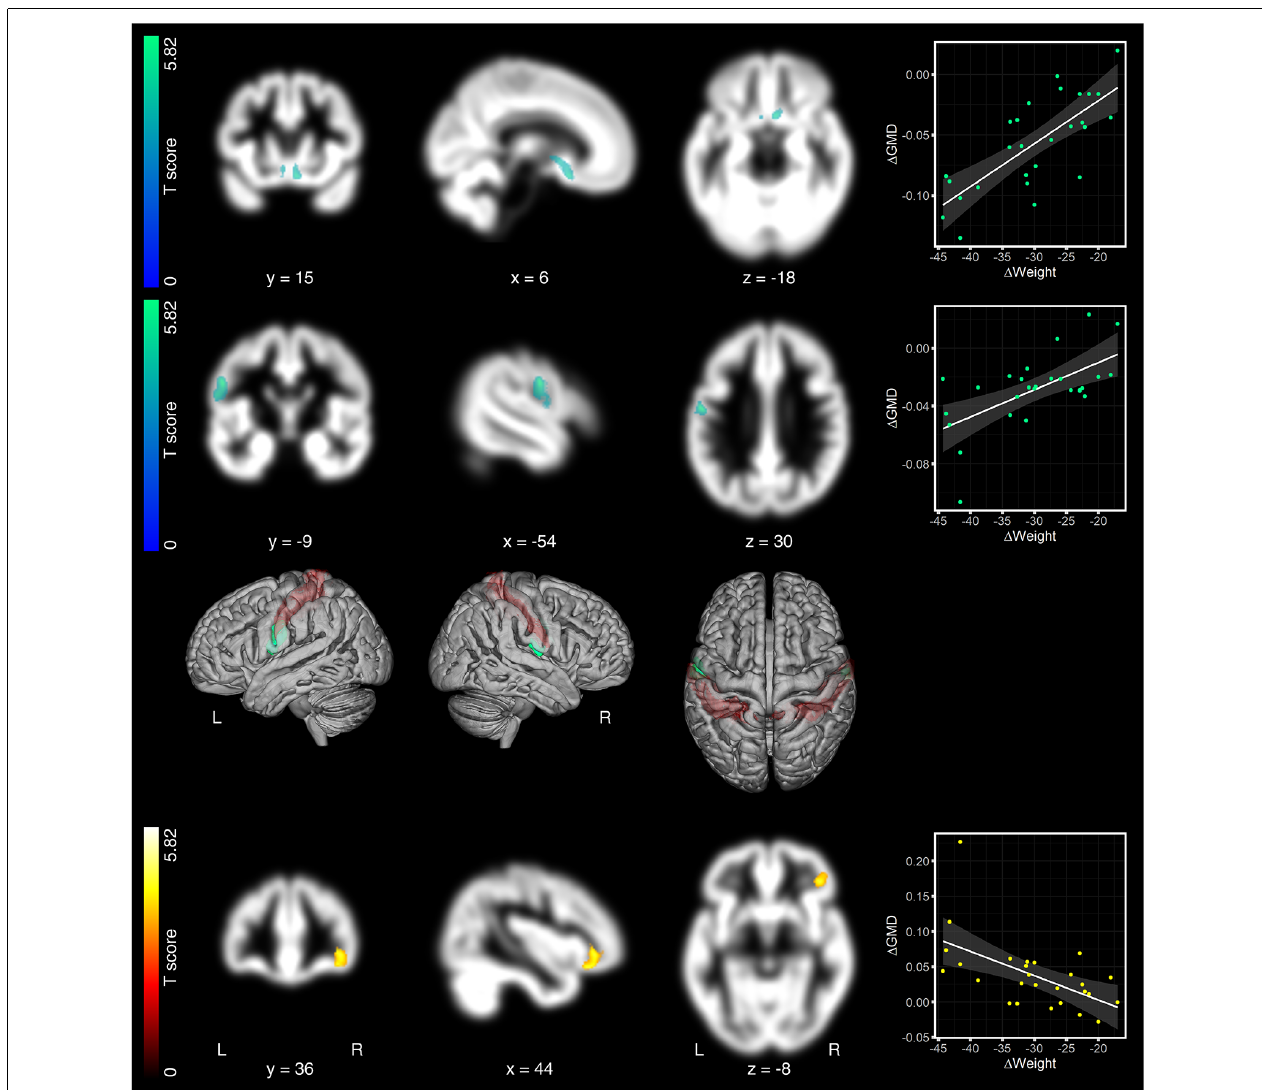
FIGURE 2 | Regression analyses between changes in gray matter density (GMD) maps and weight, 6 months after surgery. The loss of body weight (in kg) from pre to 6 months after surgery was associated with decreased GMD in the hypothalamus (top row) and the left postcentral gyrus (second row). In right postcentral gyrus, directly opposite to the left-sided cluster, we identified another cluster, which did not survive significance threshold. Due to the symmetry of both clusters across both hemispheres, we considered this non-significant cluster, nevertheless, as relevant for the discussion (third row). The only region that presented significantly increased GMD was the right lateral OFC (bottom row). Significant GMD clusters are projected on patients’ mean GMD template. Hot colors indicate positive and cold colors negative associations. GMD effects are presented on a coronal, sagittal, and axial brain slice (from left to right). Coordinates below each brain slice indicate clusters’ peak coordinates in Montreal Neurological Institute (MNI) space. “L” indicates the left, “R” the right brain hemisphere. The color bar on the left side indicates the T -scores for the cluster presented in that row. In the 3rd row, we superimposed effects on both postcentral gyri on a rendered brain. Postcentral gyri are colored in red. Scatter plots on the right to the brain slices show the relationship between changes in GMD and changes in weight. Changes in GMD, as shown in the scatter plots, were extracted as the 1st Eigenvariate at p = 0.025 family-wise error (FWE), cluster-threshold and p = 0.0005, uncorrected peak